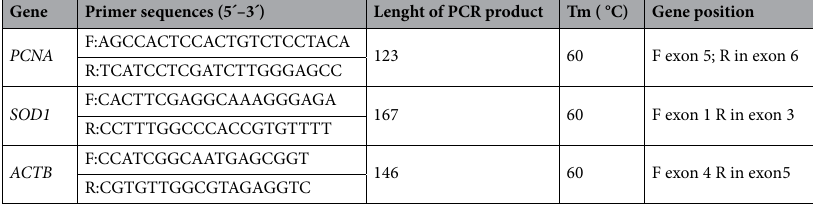
for 2-cells stage and at 8th day of culture, for blastocyst stage development. Embryo observations and images were captured with Nikon Eclipse Ti2-U inverted microscope using Octax EyeWare Imaging Software (version 2.3.0.372).